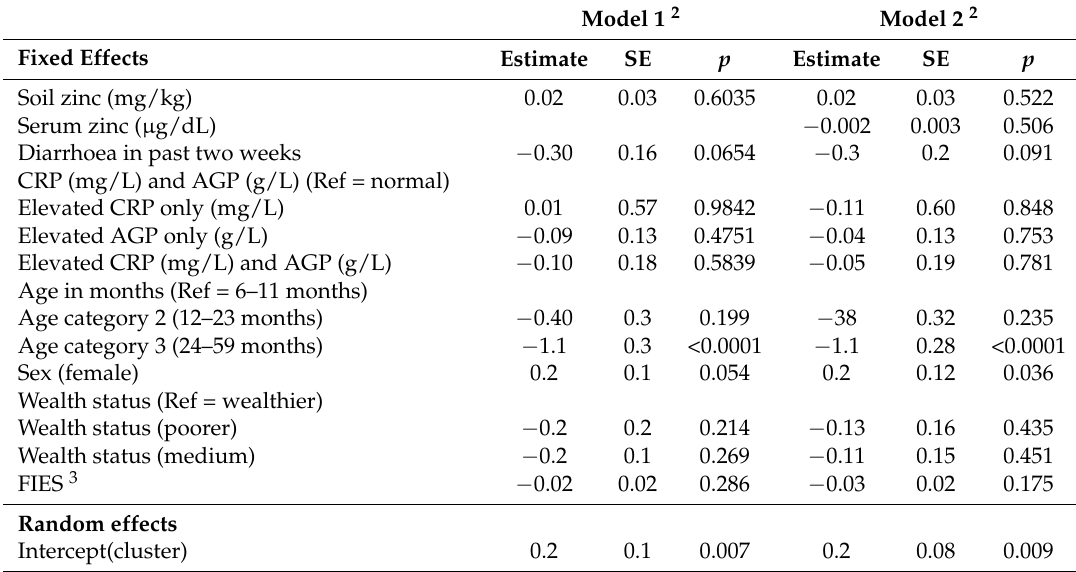
Table 5. Multi-level mixed linear regression models predicting height-for-age Z-score 1 ( n = 1673).